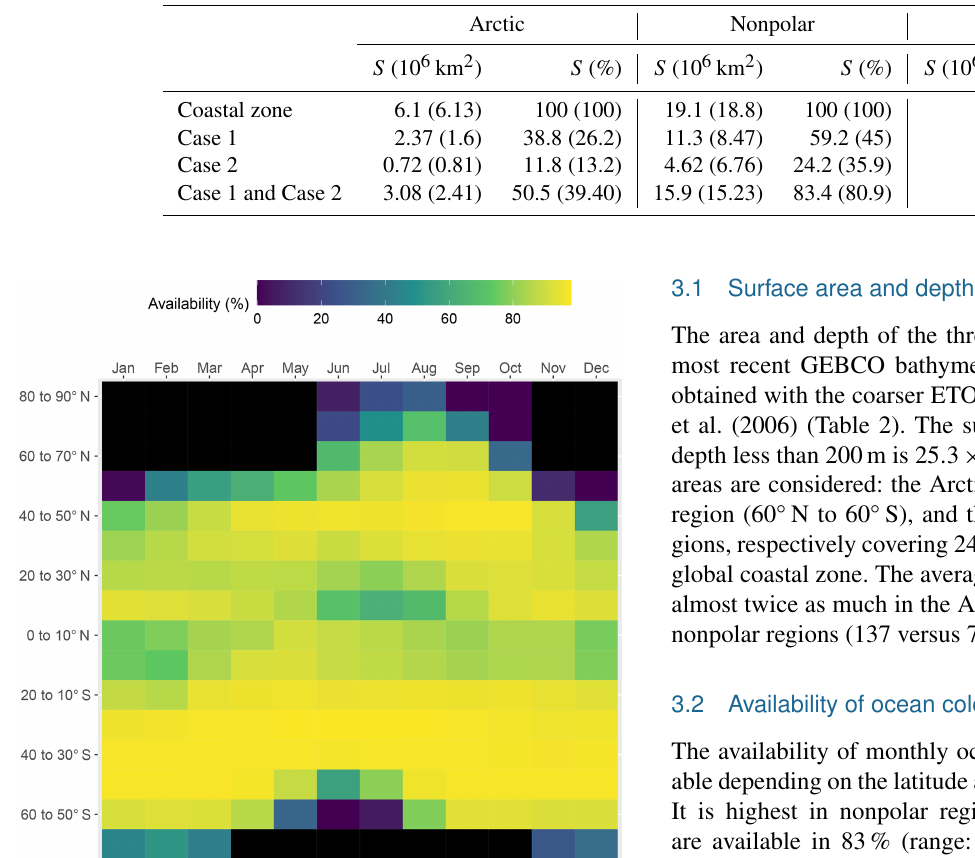
Table 2. Surface area ( S ) of coastal waters (depth < 200m) of different optical characteristics. Calculations were performed on monthly products. Values reported by Gattuso et al. (2006) are shown in parentheses for comparison. Gattuso et al. (2006) did not report data for the Antarctic.